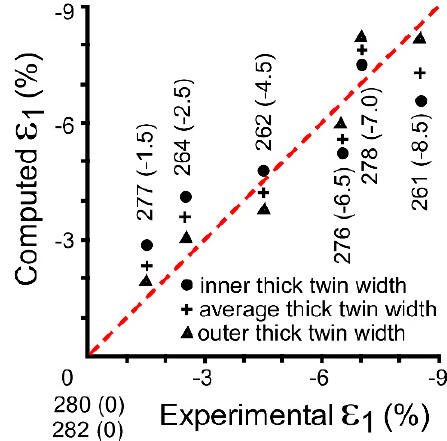
Figure 2. Computed vs. experimental maximum shortening strain ( ε 1 ) as a function of different thick-twin width measurements, all data (modified from [5]). Sample numbers (vertical) are followed by the experimental axial shortening in percent. A dashed line represents perfect agreement. Samples 280 and 282 were maintained at zero axial shortening while being loaded by confining pressure.